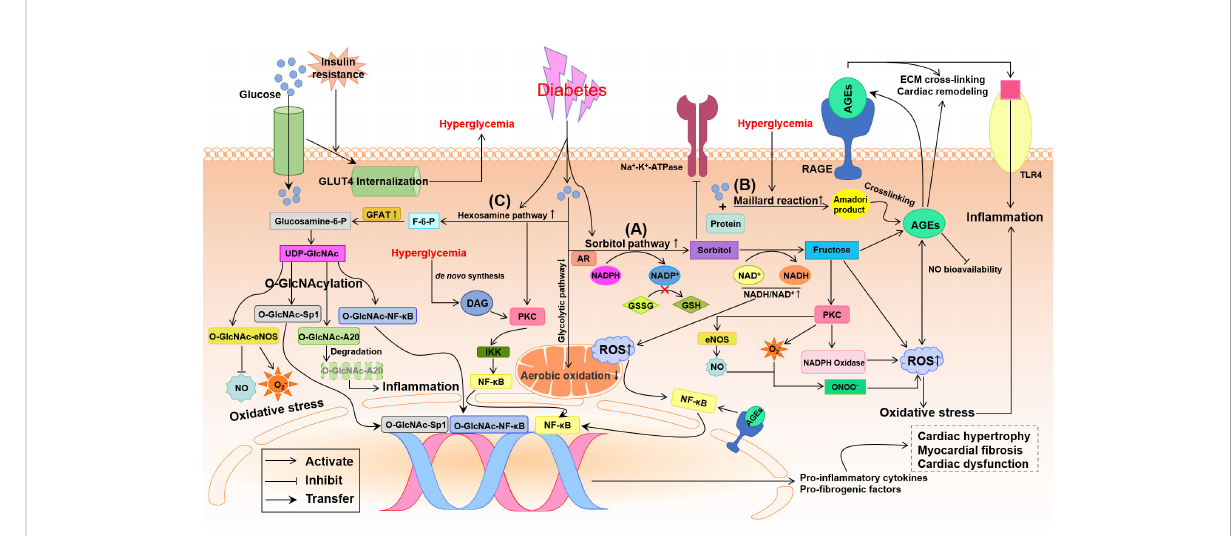
FIGURE 2 Potential pathways by which glycometabolism disorder damages the diabetic heart. Insulin resistance promotes the internalization of glucose transporter 4 (GLUT4) that means the decrease of transmembrane GLUT4 to inhibit glucose uptake in the diabetic cardiomyocyte. Oxidative stress and in fl ammation induced by the disturbance of glycometabolism involve the activation of three major pathways: sorbitol pathway, advanced glycation end-products (AGEs)/receptor of AGE (RAGE) and hexosamine pathway. (A) Up-regulation of sorbitol pathway augments oxidative stress through decreasing the reduced glutathione (GSH) and increasing reactive oxygen species (ROS), which causes nuclear factor k - light-chain-enhancer of activated B cells (NF- k B)-induced in fl ammation. (B) Hyperglycemia boosts the formation AGEs and activates the AGE/ RAGE system, which results in extracellular matrix (ECM) cross-linking, cardiac remodeling, nitric oxide (NO) inactivation and oxidative stress. (C) Up-regulation of hexosamine biosynthesis in diabetes leads to O-linked N-acetylglucosamine glycosylation (O-GlcNAcylation) modi fi cation of proteins, producing O-GlcNAc-A20, endothelial NO synthase (eNOS), Sp1 and NF- k B. O-GlcNAcylation of A20 accelerates its ubiquitination and proteasomal degradation resulting in in fl ammation. O-GlcNAcylation of Sp1 and NF- k B activate the transcriptional function to up-regulate pro-in fl ammatory and pro- fi brogenic factors. O-GlcNAc-eNOS decreases NO formation while increases superoxide anion (O 2- ) production. In addition, hyperglycemia may also activate protein kinase C (PKC), directly through de novo synthesis of diacylglycerol (DAG) and indirectly through increased fl ux of sorbitol pathway and hexosamine pathway, to promote in fl ammation and oxidative stress. All these glycometabolism disorders result in cardiac remodeling and dysfunction in diabetes. AR, aldose reductase; F-6-P, fructose 6-phosphate; GFAT, glutamine- fructose-6-phosphate amidotransferase; Glucosamine-6-P, glucosamine-6-phosphate; GSSH, oxidized glutathione; IKK, I k B kinase; NADH/ NAD + , reduced/oxidized form of nicotinamide adenine dinucleotide; NADP + , nicotinamide adenine dinucleotide phosphate; NADPH, reduced form of NADP + ; ONOO - , peroxynitrite; TLR4, toll-like receptor 4; UDP-GlcNAc,